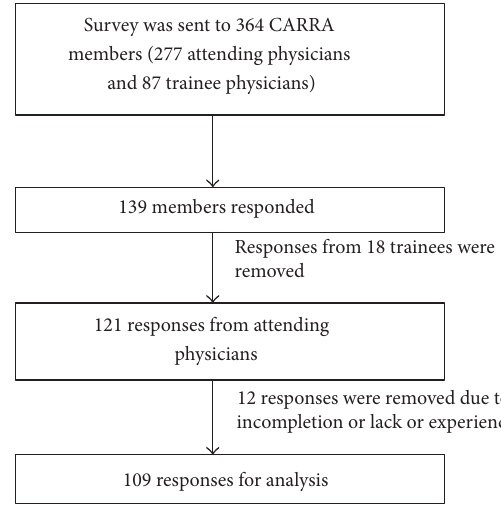
Figure 1: Illustration of responses from CARRA